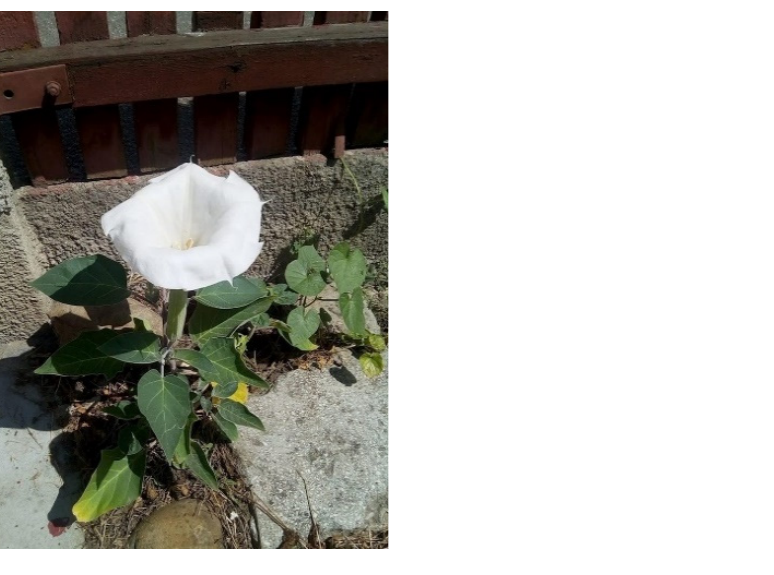
Figure 1. Datura innoxia photographed in Romania (28 December 2018) in private garden for orna- mental purpose.